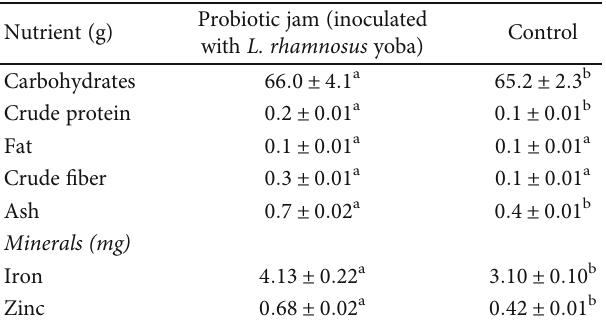
Table 2: Mineral and nutrient content of probiotic and control fruit jam per 100 g wet basis. Nutrient